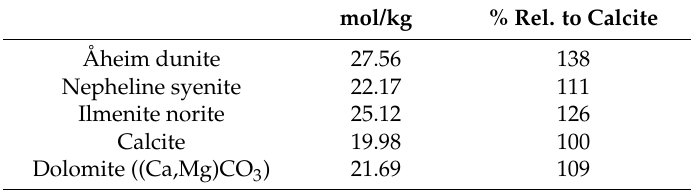
Table 4. Total potential H+ uptake per silicate powder based on major elements